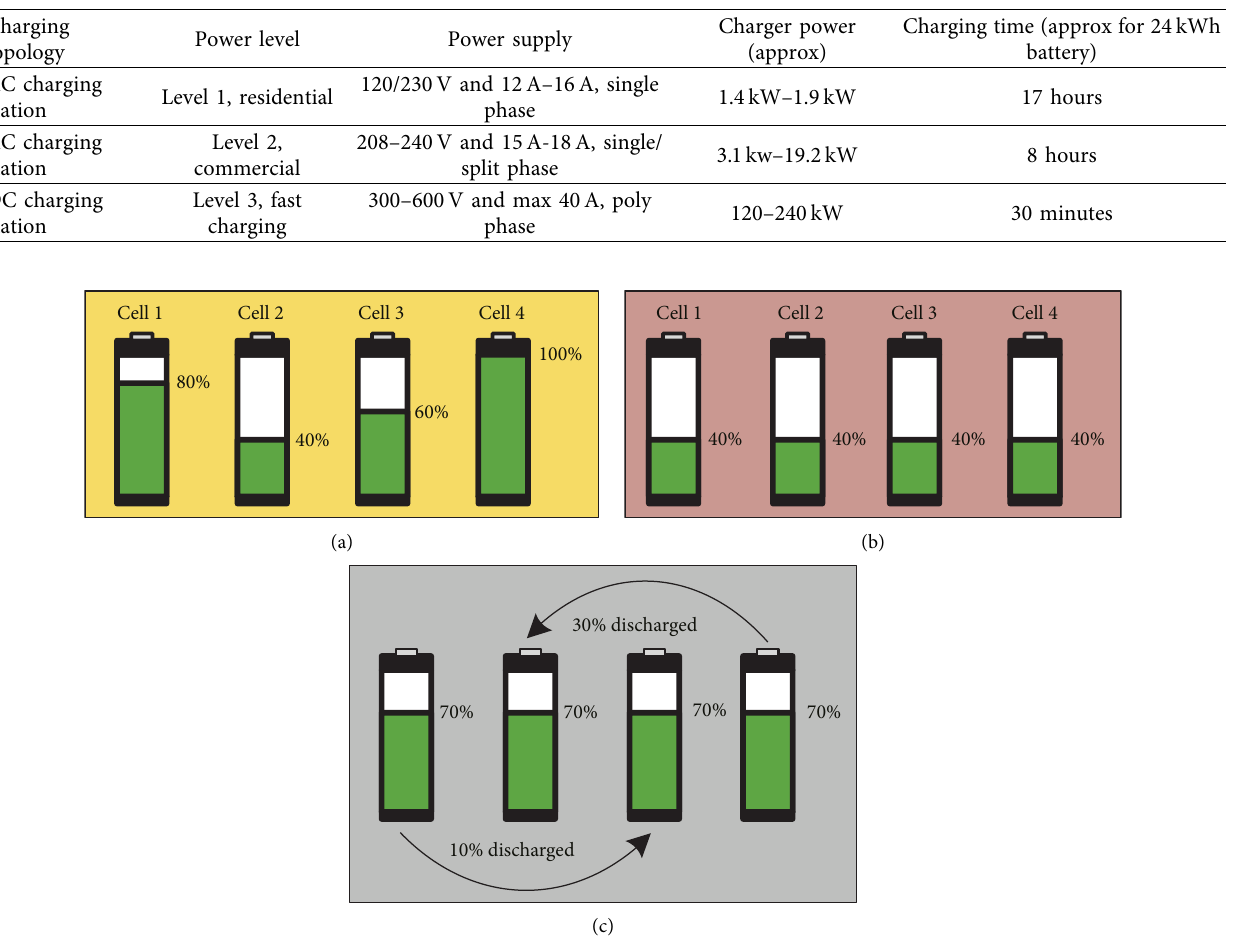
Figure 3: Battery charge equalisation methods. (a) Charge imbalance among cells. (b) Passive method of BCE. (c) Active method of BCE.